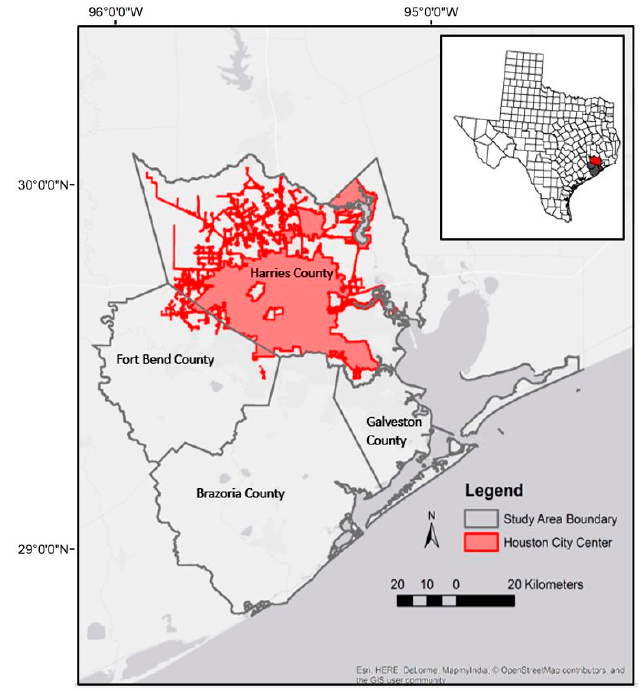
Figure 1. Study area with red polygon representing the city center extent.